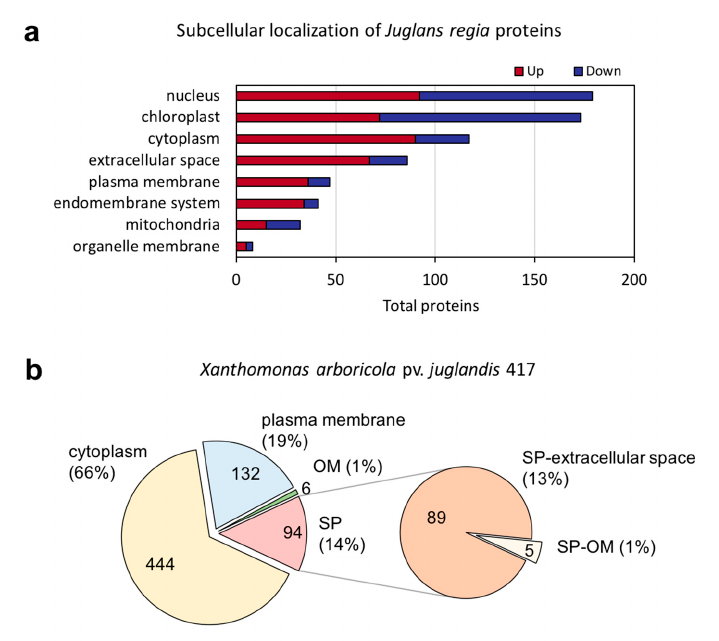
Figure 5. Subcellular localization prediction according to BUSCA. ( a ) Subcellular localization of statistically significant Juglans regia proteins with a ratio log 2 fold-change greater than two (FDR < 0.05). Increased during infection (up) and decreased (down). ( b ) Subcellular localization prediction of the 676 Xanthomonas arboricola pv. juglandis proteins. OM: outer membrane and SP: signal peptide.